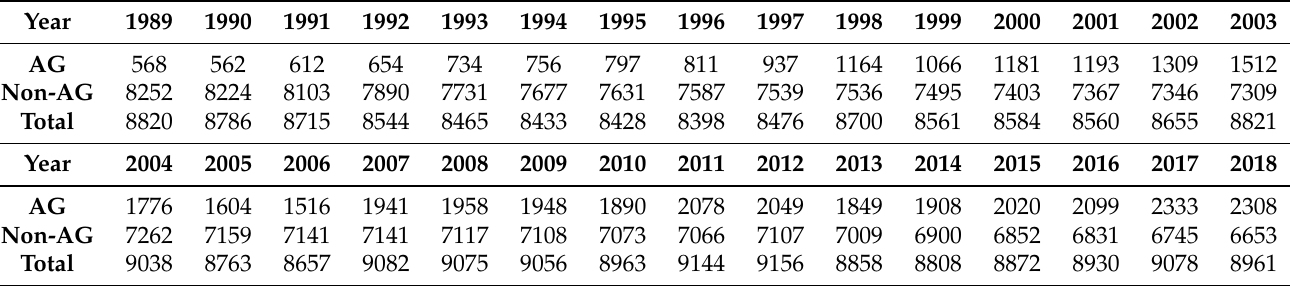
Figure 3. ( a – e ) The 10 km grid sampling structure: ( a ) and the visual-interpreted samples (red marks for AG, green marks for Non-AG) from Landsat 5 TM ( b ), Landsat 7 ETM+ ( c ), and Landsat 8 OLI ( d ). Finally, two types of reference datasets, including AG and Non-AG, were labeled via visual inspection of high-resolution imagery such as QuickBird and IKONOS available in Google Earth or Landsat imagery based on the proposed sampling structure. Meanwhile, 70% of this dataset was randomly selected as the training samples and the remaining 30% was randomly selected as the test samples to evaluate the accuracy of classification results for each year. A total of 271,729 samples were finally obtained for the period of 1989–2018, including 44,969 samples for AG and 226,760 samples for Non-AG (Table 1). Table 1. The number of training and testing samples for each class from 1989 to